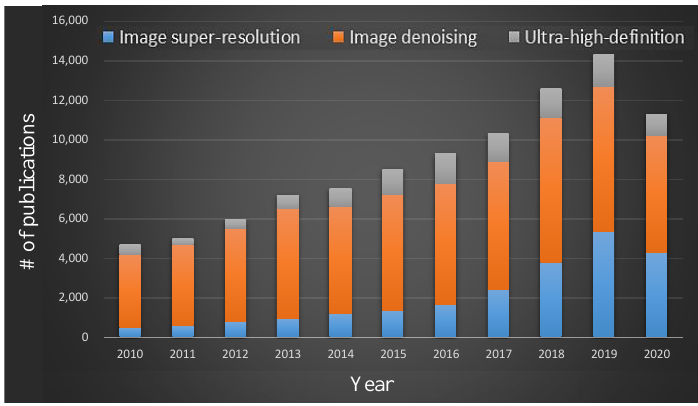
Figure 1. The numbers of publications on image super-resolution, image denoising, and ultra-high-definition.